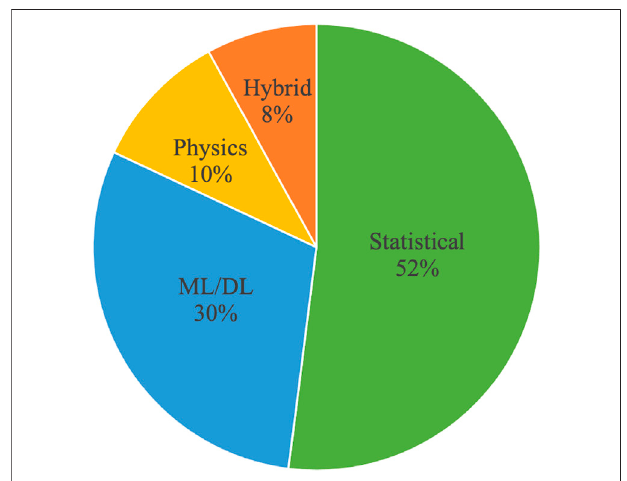
FIGURE 4 | Distribution of method categories in 274 recently published papers on machinery health prognostics [modi fi ed from Lei et al.